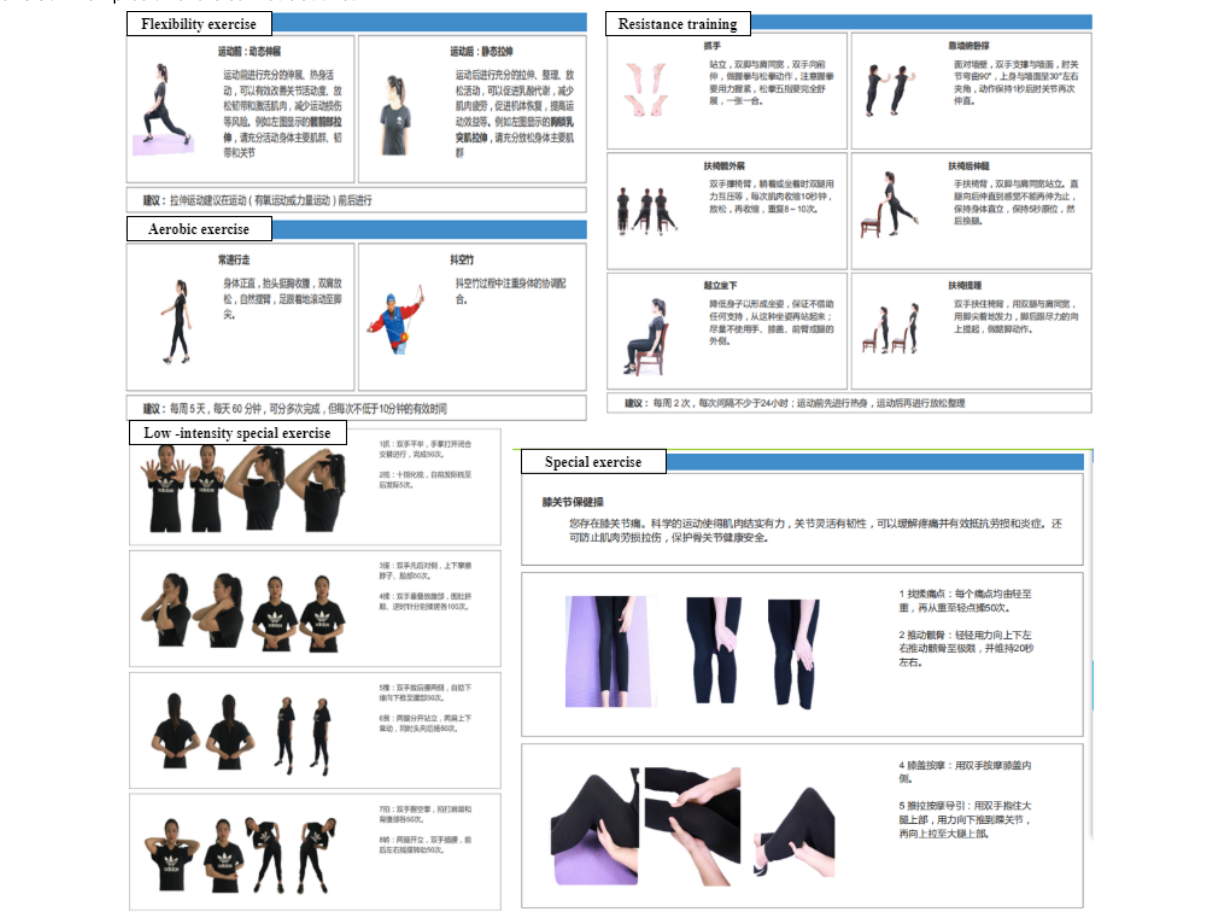
Figure 5. Examples of exercise instructions.